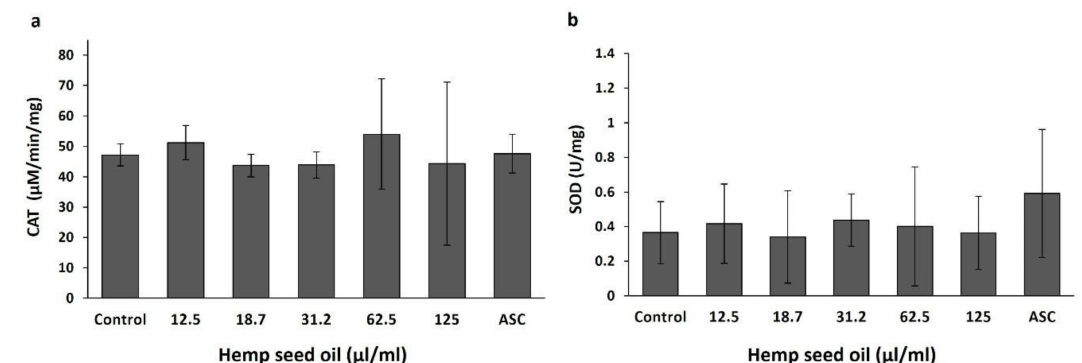
Figure 2. Effects of hemp seed oil on activities of the antioxidative enzymes catalase (CAT) ( a ) and superoxide dismutase (SOD) ( b ) in D. melanogaster larvae. The hemp seed oil was applied to the feeding medium at six concentrations (0 (control), 12.5, 18.7, 31.2, 62.5, and 125 µ L/mL) compared to a positive control of the antioxidant ascorbic acid (ASC). All values are expressed as means ± SD. There were no statistical differences between treatments ( p > 0.05, LSD test).